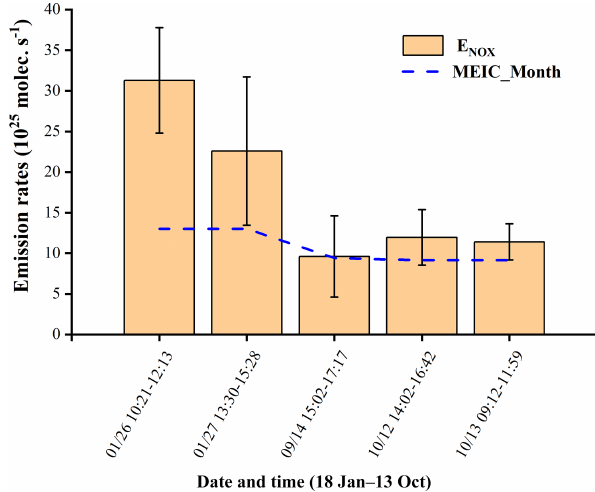
Figure 11. Journey-to-journey variations in estimated E NO corresponding monthly emission rate from the MEIC inventory (MEIC_Month) within the 6th Ring Rd of Beijing in January, September, and October 2014. Error bars represent the uncertain- ties in estimated E NO x